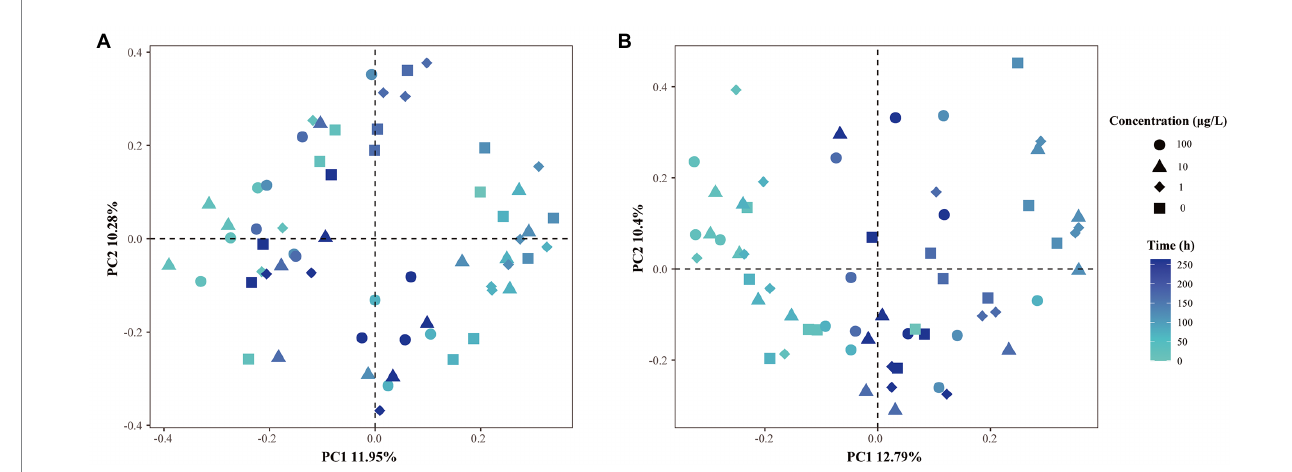
FIGURE 3 PCoA analysis of β -dispersion based on different grouping principles. (A) Distances between samples from site N2 with different concentrations of E1 added at different time scale; (B) distances between samples from site N15 with different concentrations of E1 added at different time scale. Different shapes represent different concentrations of E1. The color of dots from light to dark represents changes over